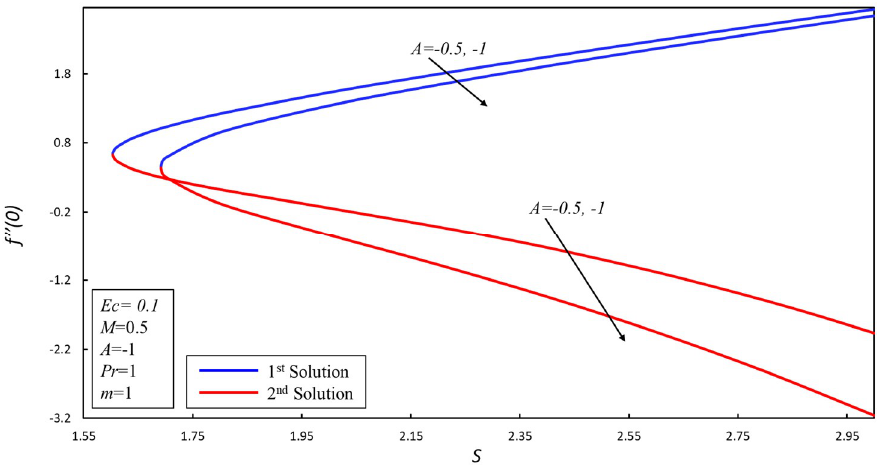
Figure 7. Coe ffi cient of skin friction for di ff erent values of A . Figure 7. Coefficient of skin friction for different values of A . Figure 7. Coefficient of skin friction for different values of A .